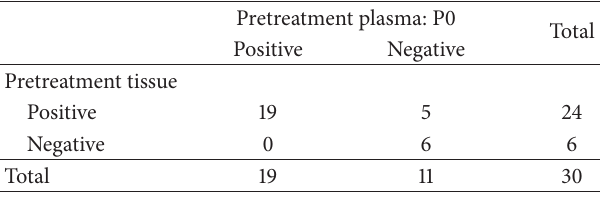
Table 2: Correlation of EGFR mutation status between tissue and plasma samples before EGFR-TKI